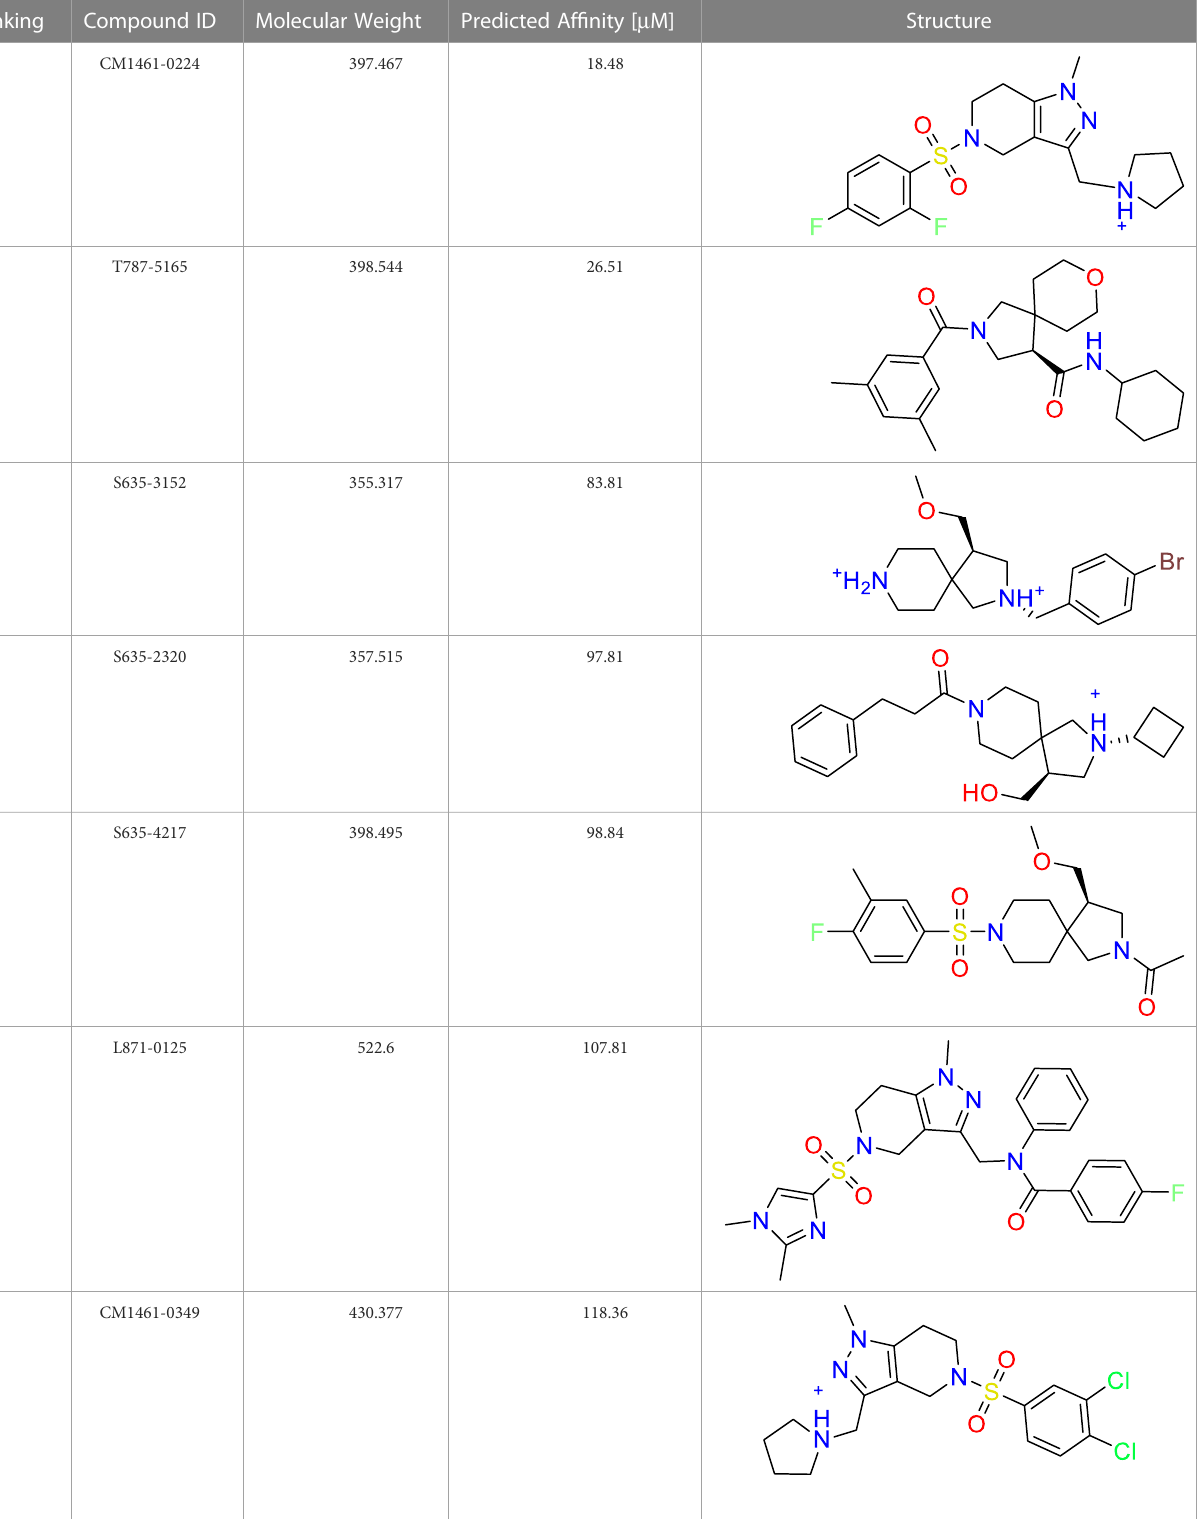
TABLE 2 The top 10 compounds docked to LexA using BioSolveIT, with HYDE rescoring predicted af fi nities (Schneider et al.,